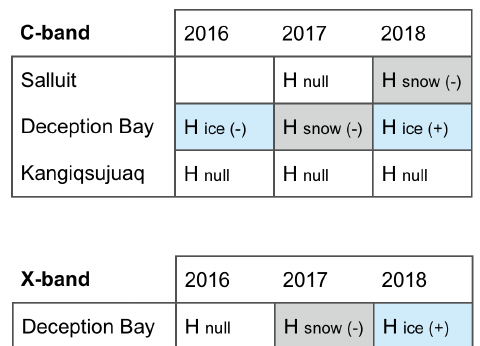
Figure 6. Most likely hypothesis in the Bayesian linear regression analysis for HH backscattering vs snow depth and ice thickness, out of the null ( H 0 , in white), snow ( H snow , in gray), and ice ( H ice , in blue). The sign of the linear relationship is identified with a plus or minus